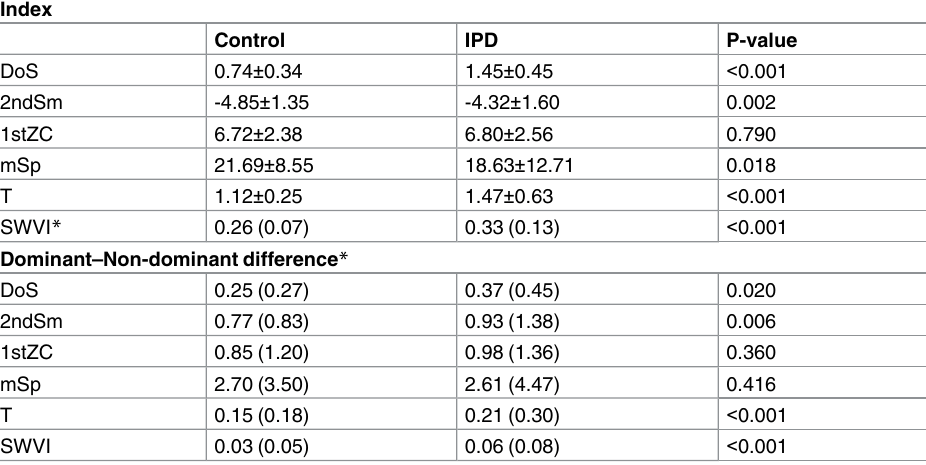
Table 2. Dominant-hand Spiral Indices and Dominant–Non-dominant differences for PD Subjects and Controls.